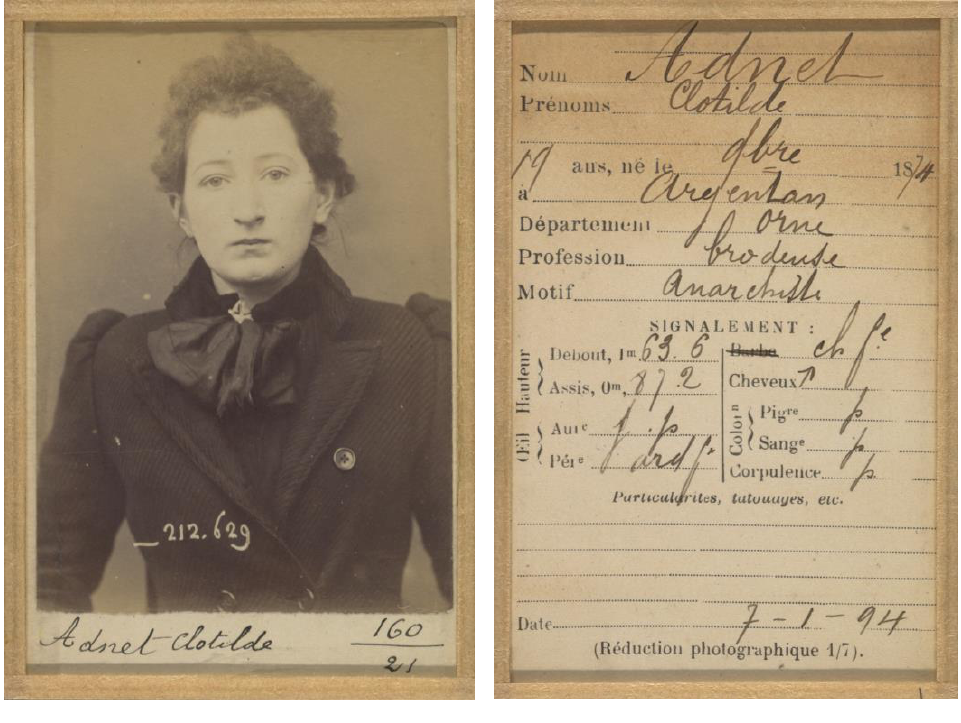
Alphonse Bertillon, Adnet. Clotilde. 19 ans, née en décembre 74 à Argentant (Orne). Brodeuse. Anarchiste. Fichée le 7/1/94 , 1894, Albumen silver print from glass negative, 10.5 x 7 x 0.5 cm, Gilman Collection, Metropolitan Museum of Art, New York